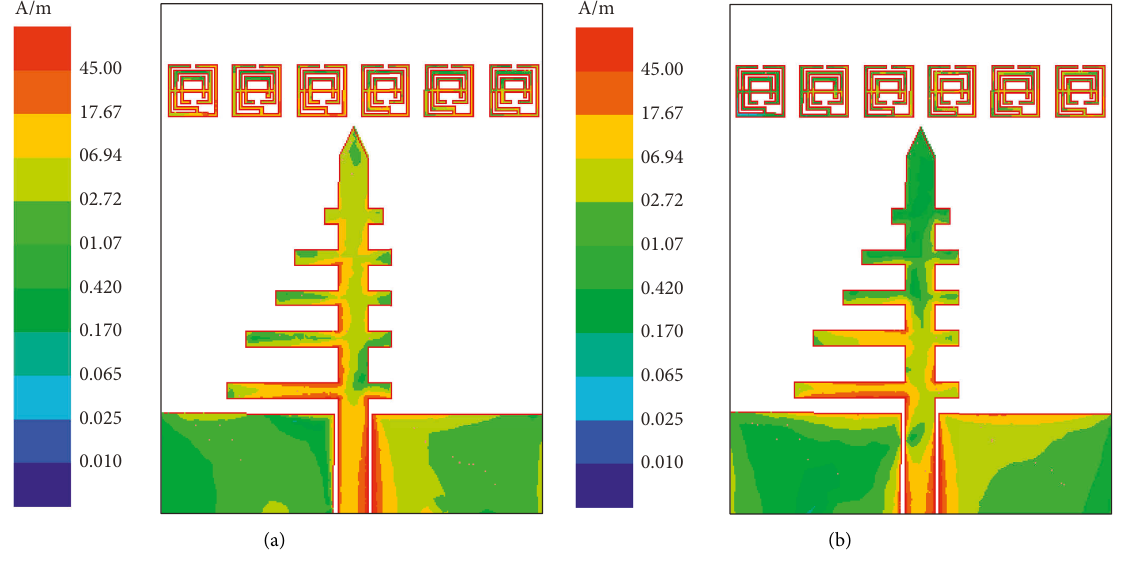
Figure 11: Surface current distribution on the PLPA at (a) 3.5 GHz and (b)